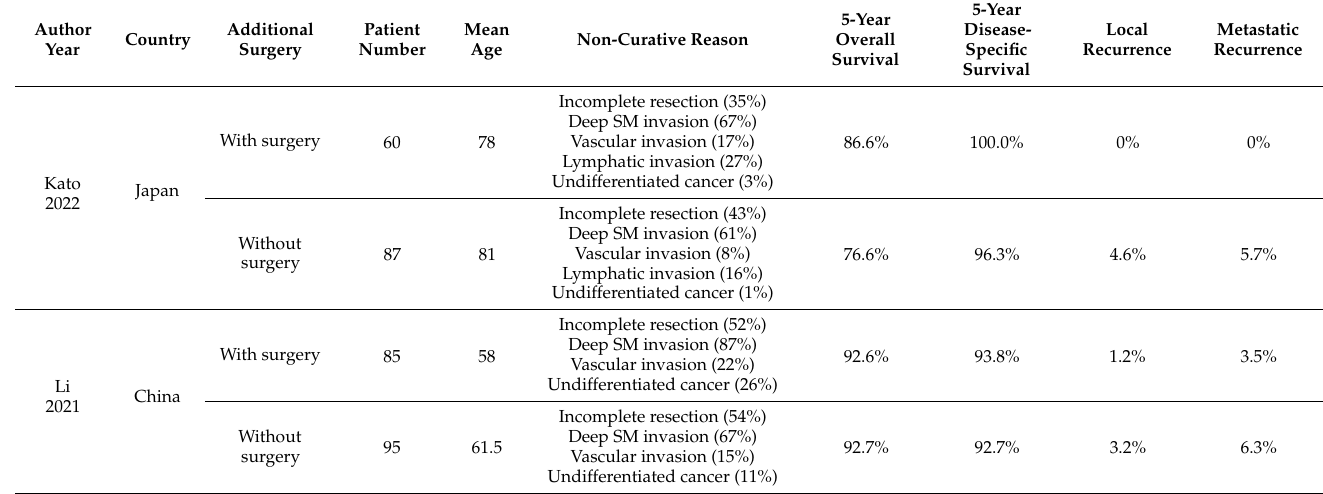
Table 4. Non-curative resection with and without surgery, and long-term